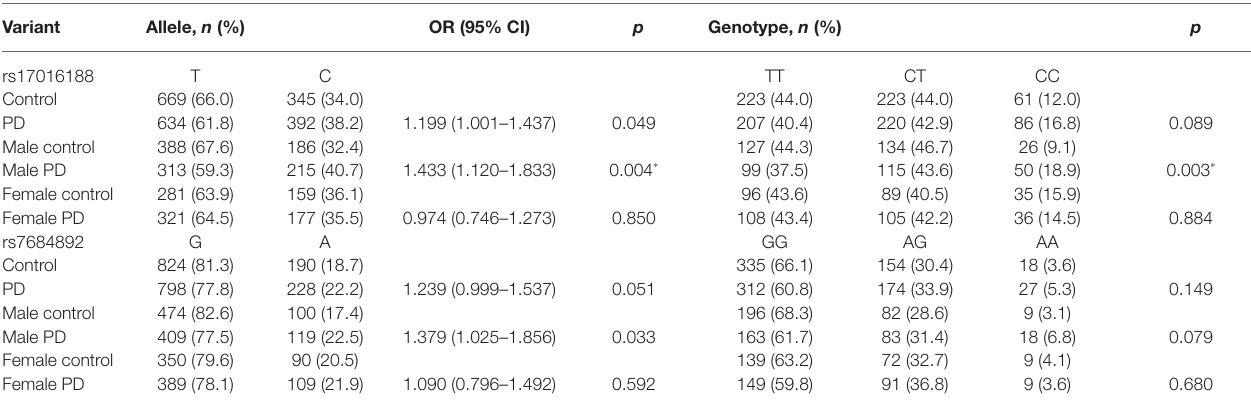
TABLE 2 | Association analysis of rs17016188 and rs7684892 with PD risk. Variant Allele, n